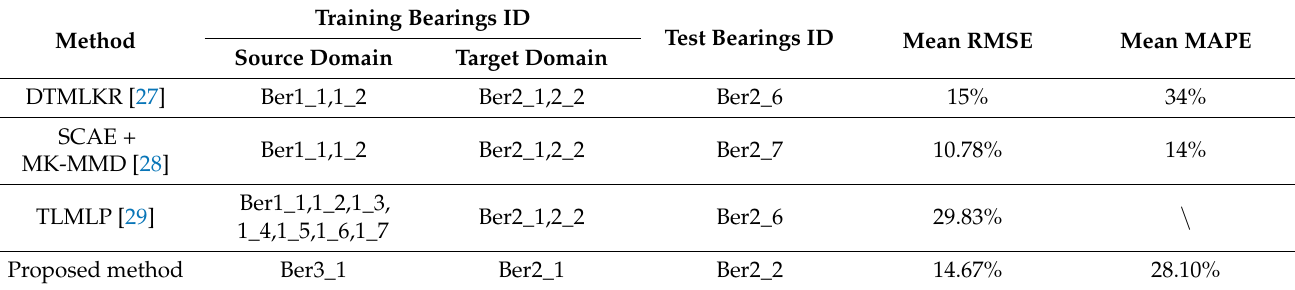
Table 5. Performance comparisons of related